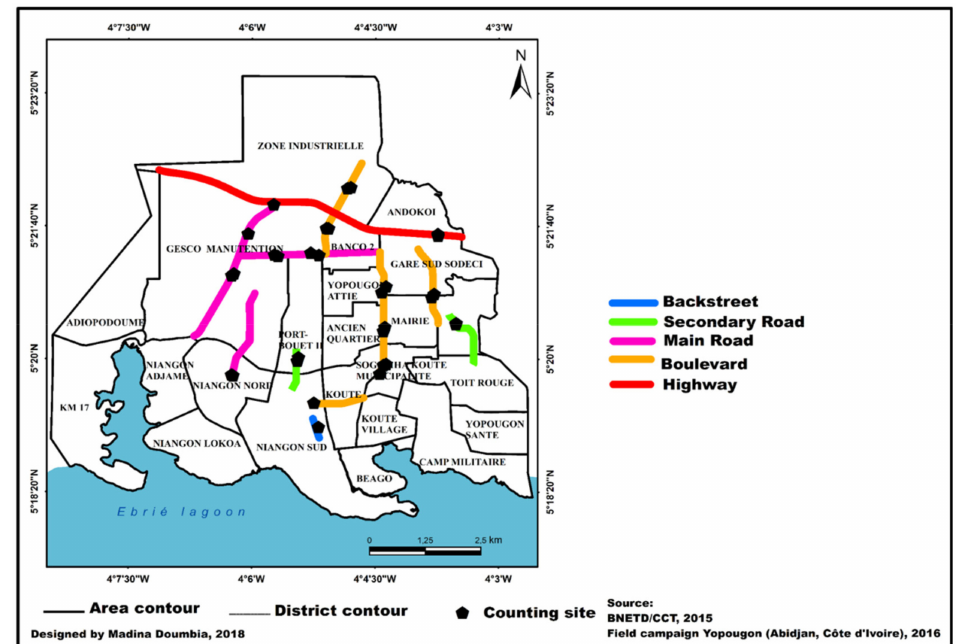
Figure 1. Different road types of the road network in Yopougon. Red line represents the highway, blue line is for the backstreet, pink lines are the main roads, green and orange are the secondary roads and boulevards, respectively. Location of counting point of vehicle fleet composition over several road types in Yopougon in Doumbia et al.